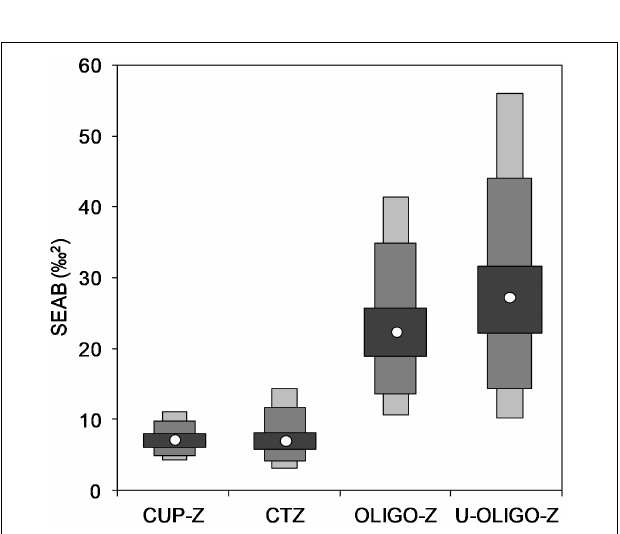
FIGURE 4 | Layer isospaces of five size fractions for δ 13 C and δ 15 N, including the individual measurements of the samples for each zone: (A) CUP-Z, (B) CTZ, (C) OLIGO-Z and (D) U-OLIGO-Z. The maximum likelihood calculated of standard ellipse areas for each size fraction (continuous line).